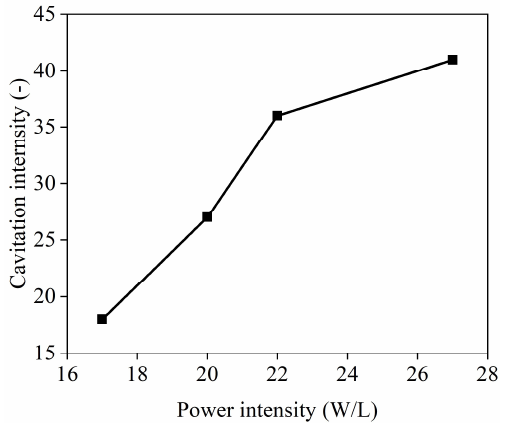
Figure 6. Effect of power intensity on cavitation intensity in a 40 kHz ultrasonic cleaner (25 °C, 15 L water) (modified from [46]).